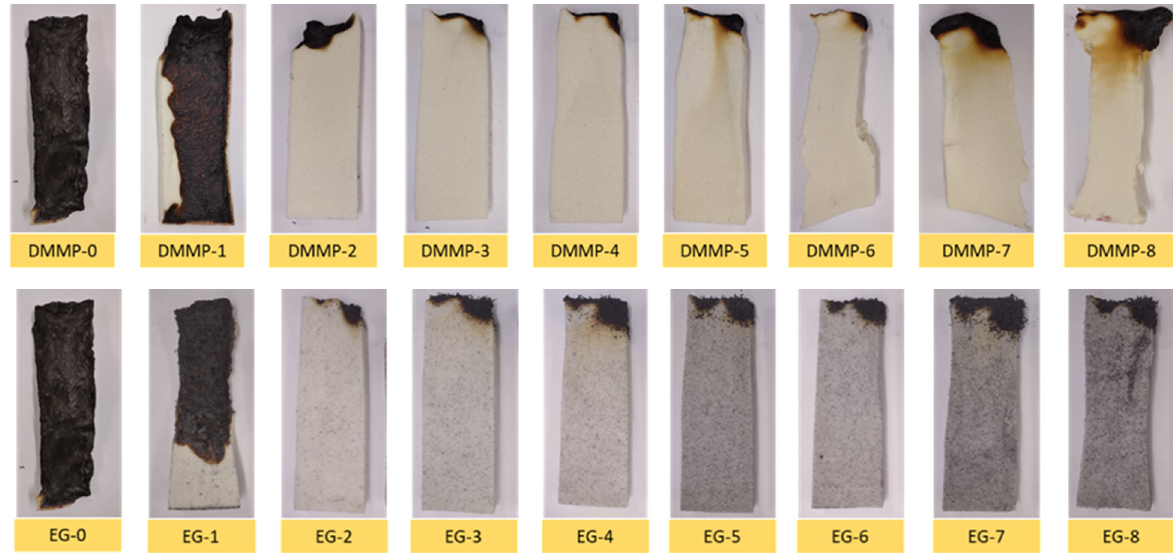
are formed as byproducts during the polyurethane’s combustion [44,52,53]. After that, the phosphorus-based radicals can precipitate in the form of phosphoric acid and go through a a protective char layer that prevents further degradation of the polyurethane [3,48,54]. The aspect of this char layer can be observed in Figure 7. Hence, it is likely that DMMP has a burnt area of the foam drastically reduced as compared to the pure rigid sunflower-based flame retardancy mechanism that functions in both the gas and solid phase. polyurethane foam.